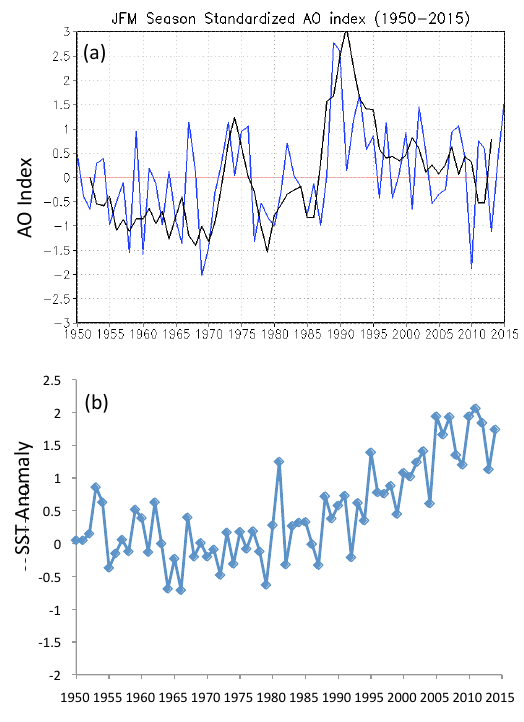
Figure 13. (a) winter and annual indices of the Arctic Oscillation from a950 to 2015 and (b) SST anomalies in the Arctic region for the same period.